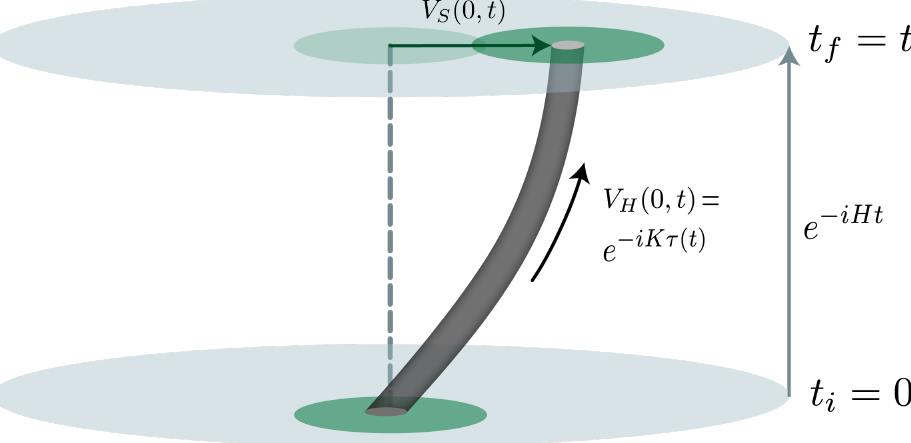
= 0 atmosphere i = t . V f S